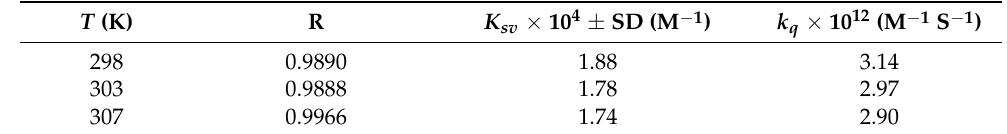
Figure 2. The fluorescence spectra of the ( A ): BSA-ETB binary system and BSA-ETB ternary system in presence of flavonoids, ( B ): RUT; ( C ): NAR; and ( D ): SIN). BSA (1.5 µ M) with a: ETB (0.00–27.5 µ M); and (RUT, NAR, and SIN) = 5.5 µ M at ( λ ex = 280 nm and λ em = 300–500 nm). Table 1. Stern Volmer K sv and bimolecular quenching constant k q .